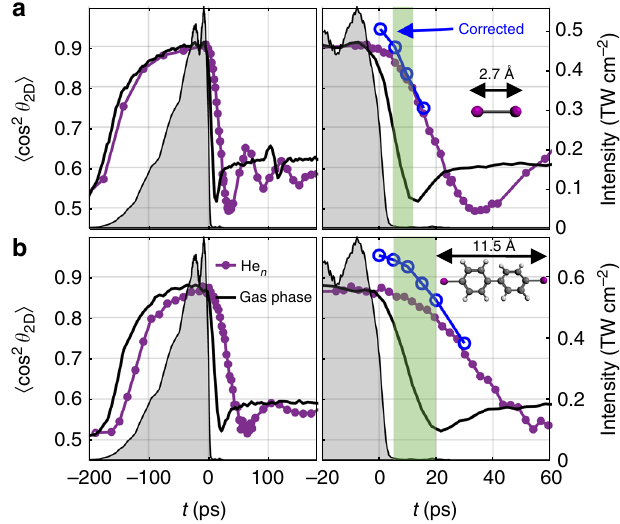
Fig. 1 1D alignment of I 2 and diiodobiphenyl. Alignment dynamics of I 2 ( a ) and h i and recorded as a 4,4 ′ -diiodobiphenyl ( b ) molecules, represented by cos 2 θ 2 D function of time. The measurements are conducted both for isolated molecules (black curves) and for molecules in He droplets (purple curves) under identical laser conditions. The intensity pro fi le of the truncated alignment pulse is shown by the grey shaded area and refers to the right vertical axis. The panels on the right show a zoom of the post-truncation region. The green shaded area in each panel marks the interval where the alignment fi eld intensity is <1% of its peak h i (cid:2) 0 : 80. The structure of each molecule is inset, along with a and cos 2 θ 2 D h i after scalebar representing the I – I distance. In droplets, the values for cos 2 θ 2 D correction for non-axial recoil at selected times are also shown as blue open